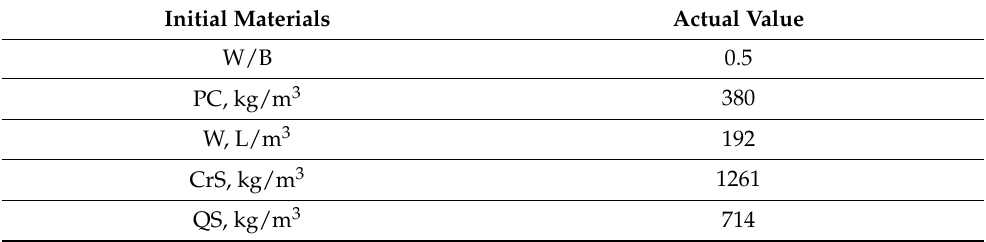
Table 4. Composition of the CM.